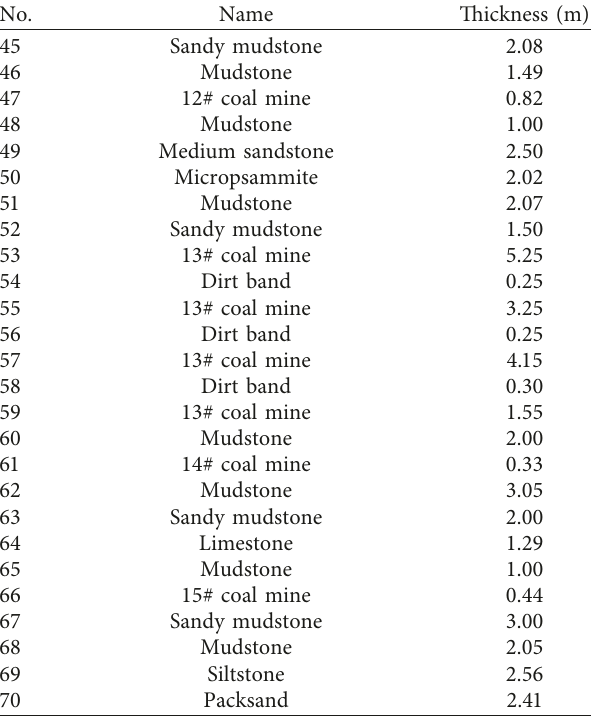
Figure 1: Structure of the roof. 1: irregular fall zone; 2: regular caving zone; 3: fractured zone. Table 1: Rock formation columnar section of the 13# coal seam in the Xiegou coal mine.